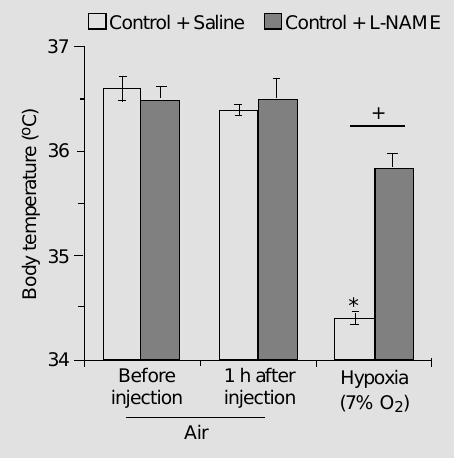
Figure 5 - Combined effect of hypoxia and intracerebro- ventricular ( icv ) injection of N G -nitro-L-arginine methyl ester (L-NAME; 250 µg/µl) on body temperature of saline- and L-NAME-treated rats (N = 7 for both groups). Values are reported as means ± SEM. *Significant drop (P<0.05) in body temperature after hypoxia of saline group compared to normoxia. + Significant differ- ence (P<0.05) in the magnitude of